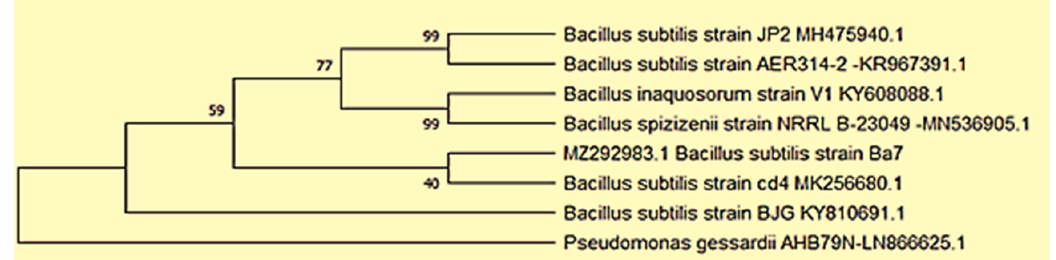
Figure 1. Constructed phylogenetic tree of partial 16S rDNA gene sequence of Bacillus isolate was constructed by neighbor-joining method with 1000 bootstraps using MEGAX. GenBank accession number of Bacillus isolate sequences are indicated in top of the branch. Pseudomonas gessardii AHB79N (GenBank accession number LN866625.1) was used as an outgroup. Bootstrap values (%) for 1000 repetitions are indicated by the numbers at nodes. The scale bar represents substitutions and nucleotide substitutions per site.